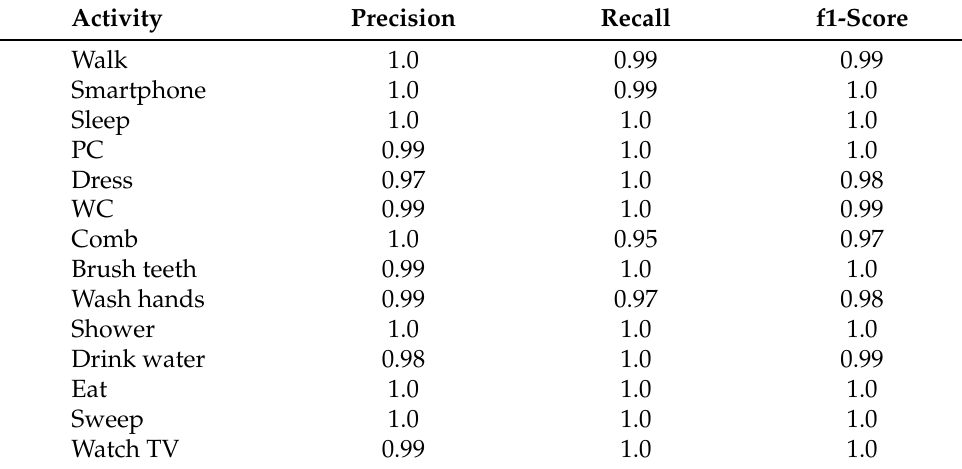
Table 4. Algorithm results in experiment 1.